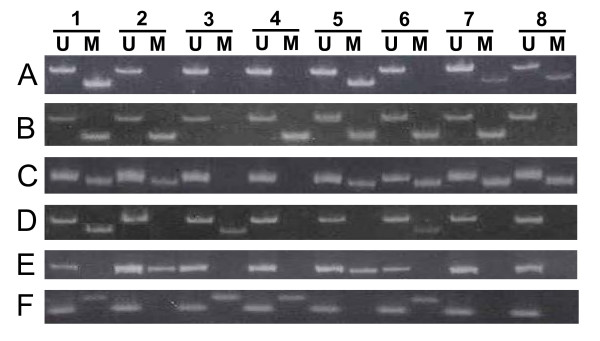
Methylated (M) and unmethylated (U) alleles for six genes produced by MSP in representative samples. (A) APC: methylated alleles were detected in cases A1, A5, A7 and A8; (B) BRCA1: methylated alleles were detected in cases B1, B2, B4, B5, B6 and B7; (C) DAPK: methylated alleles were detected in cases C1, C2, C5, C6, C7 and C8; (D) hMLH1: methylated alleles were detected in case D1, D3 and D6; (E) p16: methylated alleles were detected in cases E2 and E5; (F) PTEN: methylated alleles were detected in cases F1, F3, F4 and F6.